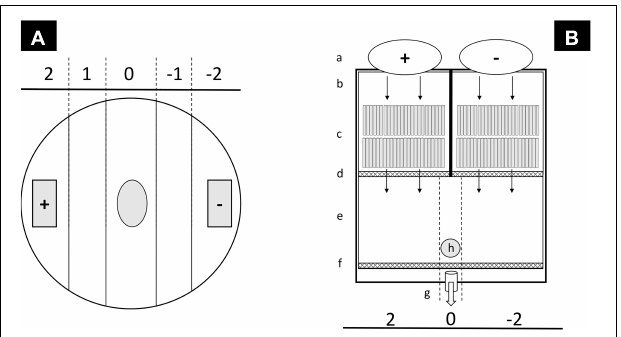
FIGURE 1 | Schematic representation of static choice experimental arena (A) and flow-through flume system (B) . In static choice experimental arena (A) , volatile organic compound (VOC)-supplemented agarose was positioned in the (+) square, while the control agarose was positioned in the (–) square. Number of individuals in each sector was recorded at each timepoint. Individuals were positioned in the center of the “0” area. In flow-through flume system (B) , (VOC)-supplemented solution (a) was dropped in water inflow compartments (b); fixed straws reduce the turbulence of the flux (c); two fine mesh (0.5 mm) nets (d and f) contain animals in test arena (e). A pipe allows the flux of water to be drained (g). Individuals were positioned in the center of the test area